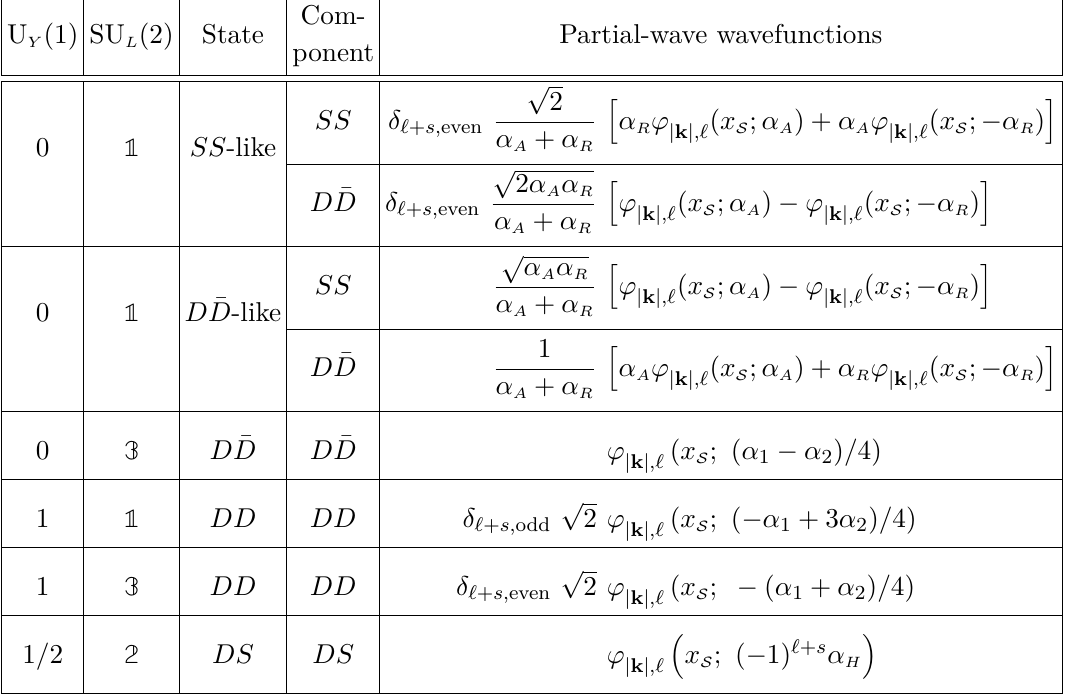
Table 3 . The scattering states and their wavefunctions in the limit m denotes the ‘ mode of a scattering state with momentum k for a Coulomb potential V ( r ) = − α/r ; the position variable is x For ‘ + s = odd, the ( 1 , 0 ) mixed states